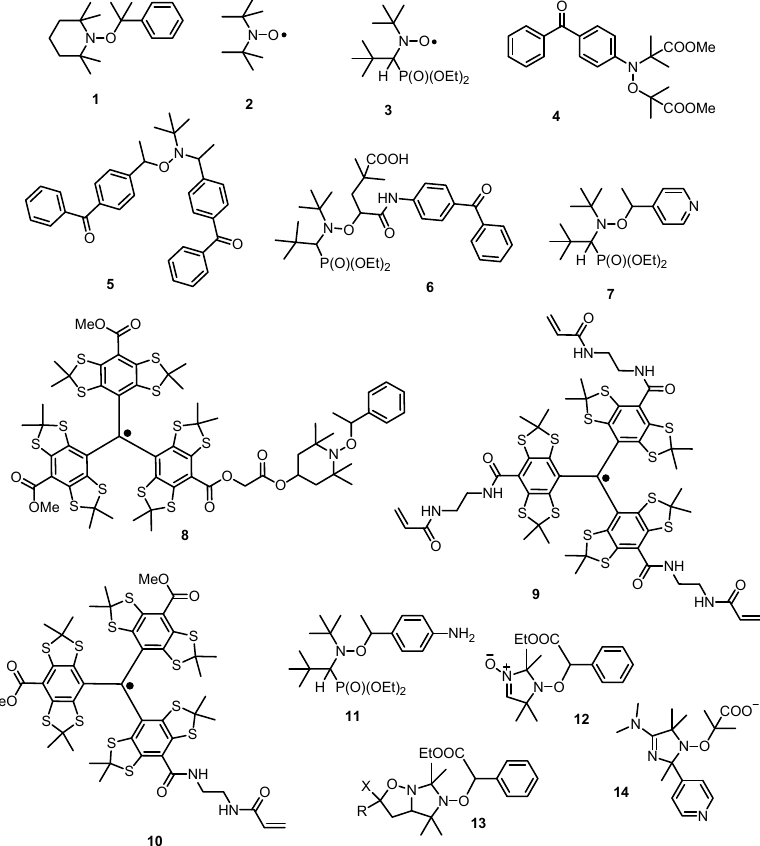
Figure 2. Alkoxyamines used to exemplify the variants of NMP